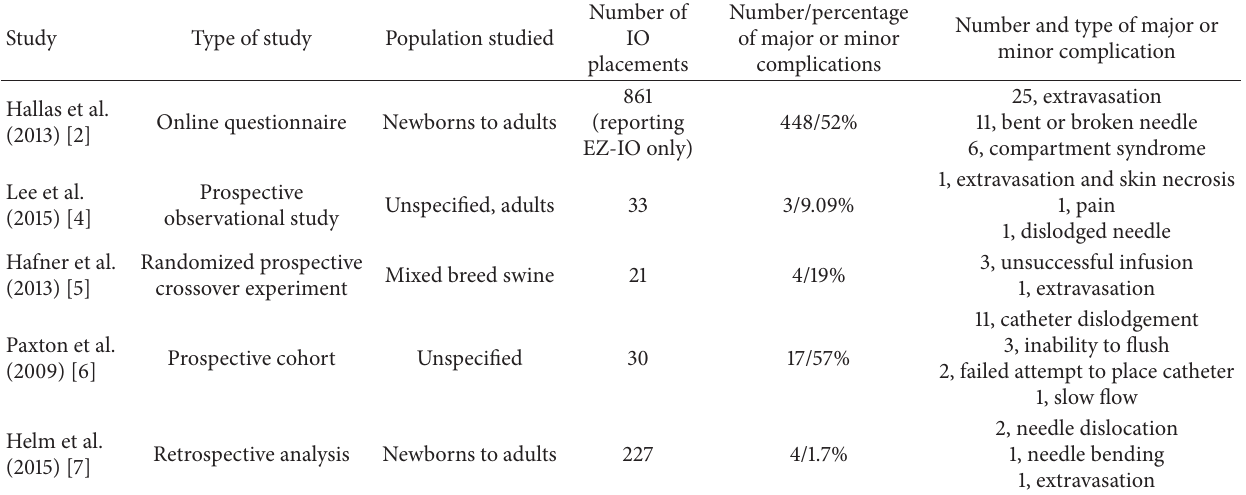
Table 1: Complications associated with IO